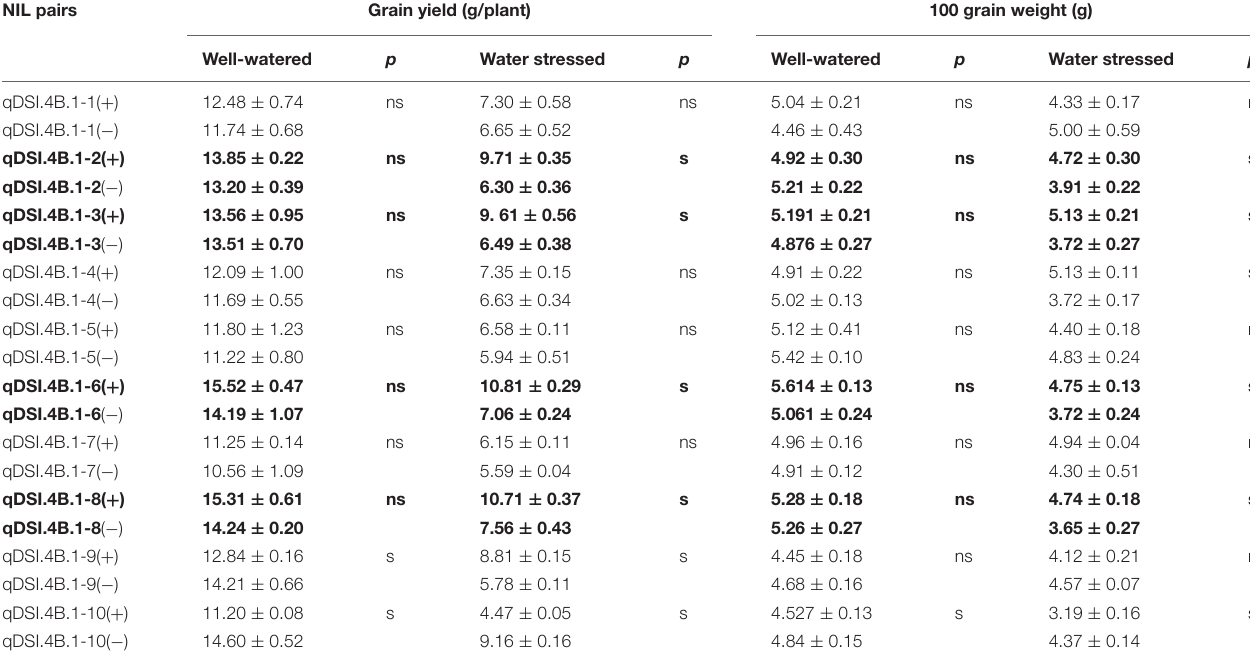
TABLE 1 | Grain yield (g/plant) and 100 grain weight (g) of the developed NIL pairs. NIL pairs Grain yield (g/plant) 100 grain weight